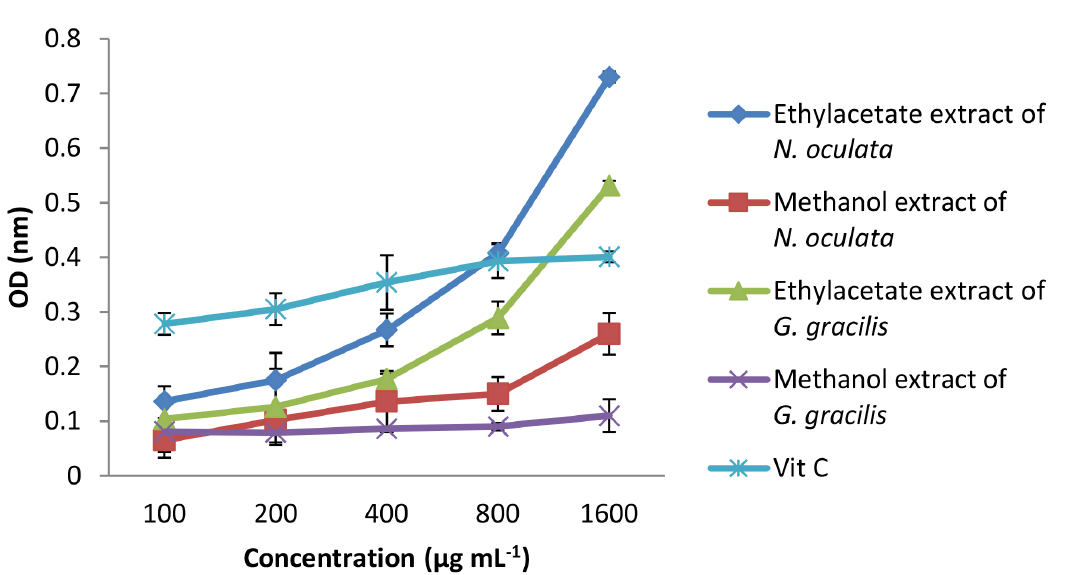
FIGURE 1 - Reducing power of ethyl acetate and methanolic extracts of algal species. Each point on the graphs represents the mean of three